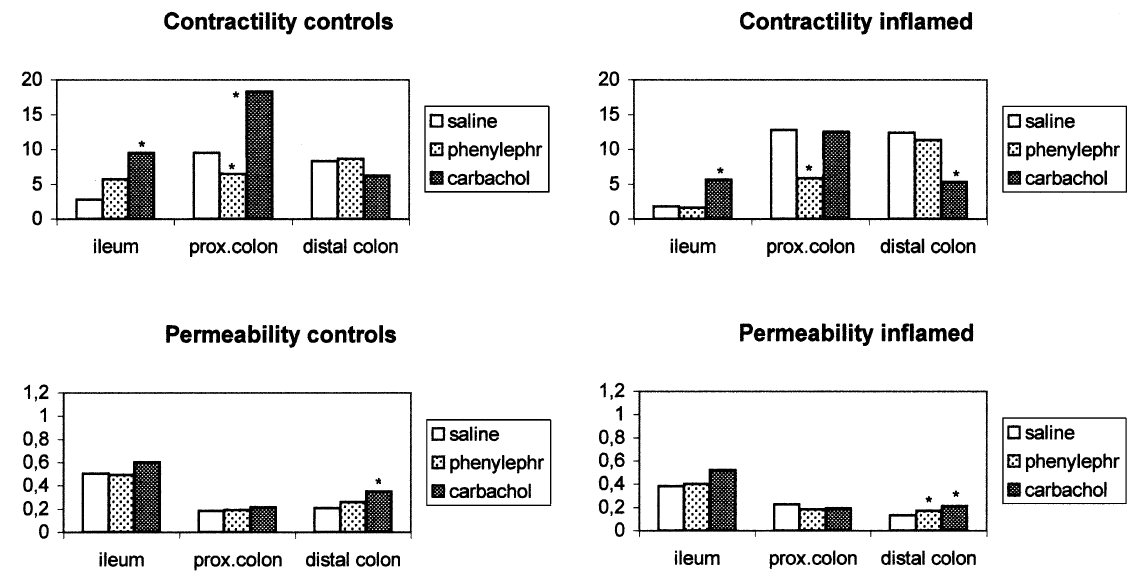
FIG. 2. Mean effects of phenylephrine (3 (cid:4) / 10 (cid:3) 6 M) and carbachol (10 (cid:3) 3 M) on contractility measured as the number of movements in intestinal segments from the ileum, proximal colon and distal colon in control mice (n (cid:5) / 6; top left panel) and DSS-induced inflammation (n (cid:5) / 6; top right panel), and on permeability determined by the PEG 4000/mannitol ratio in the same intestinal segments of control mice (bottom left panel) and DSS-induced inflammation (bottom right panel). * p B / 0.05 versus